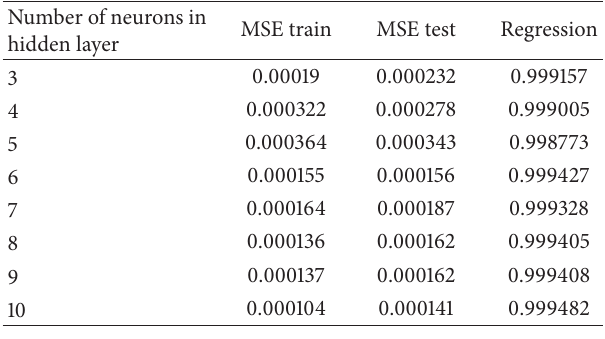
Table 2: MSE for FFBP.